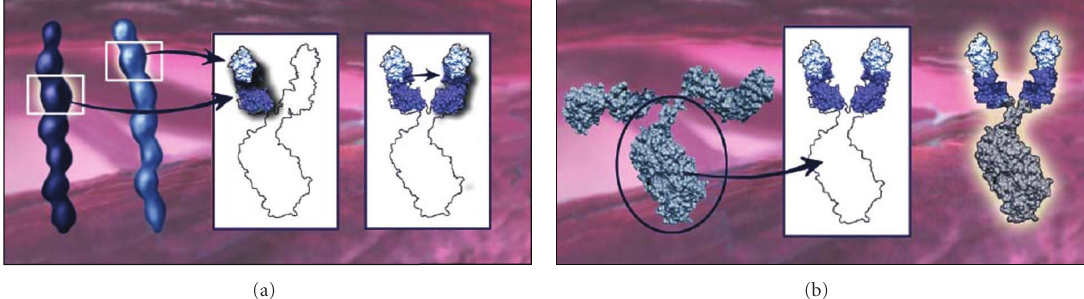
Figure 2: (a) A binding domain of VEGFR1 and VEGFR2 are fused to create 2 dual-domain arms for each VEGF Trap-Eye molecule. (b) The Fc portion of the IgG is fused to the two dual-domain arms to create the VEGF Trap-Eye molecule (see